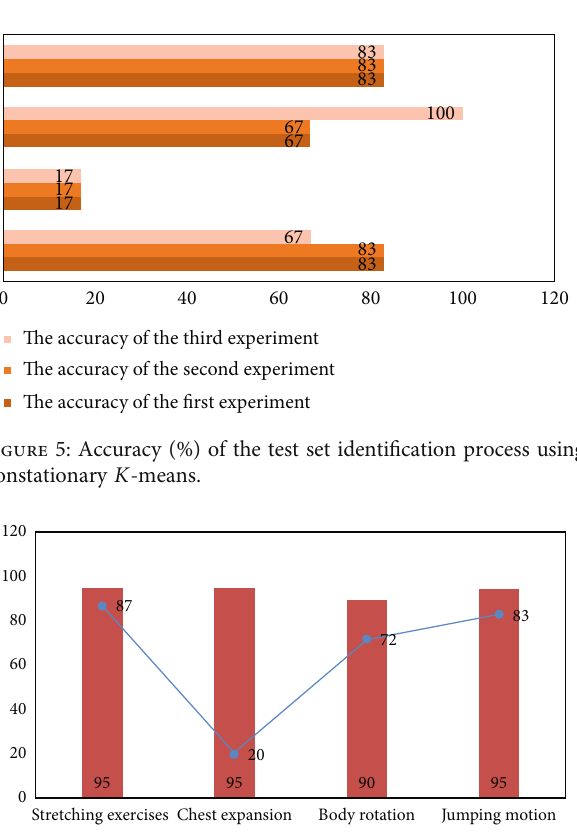
Figure 4: Comparison of the UTKinect dataset training set (%).